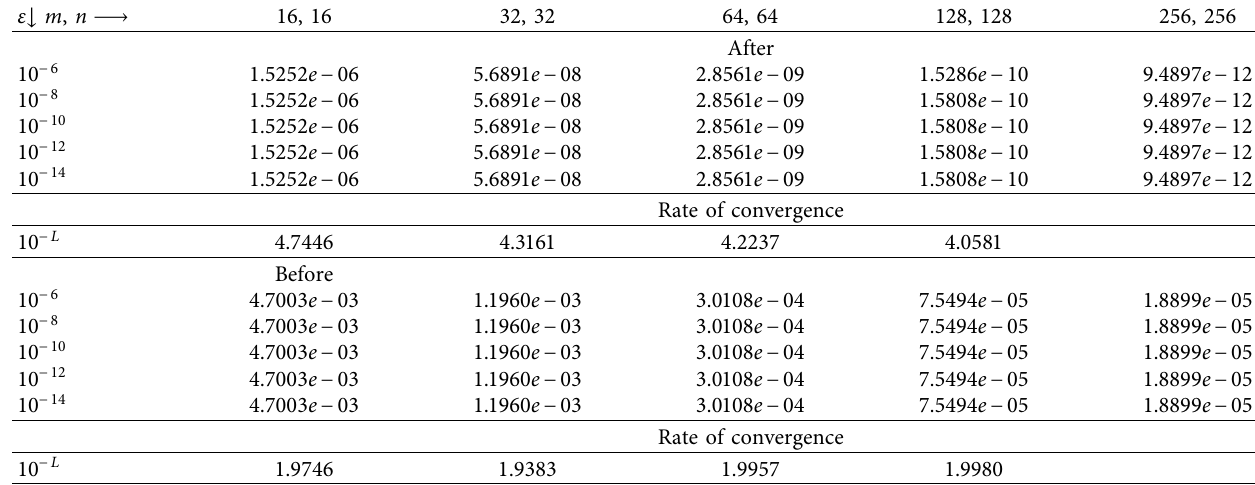
Table 2: Maximum absolute pointwise error and rate of convergence for Example 2 before and after the Richardson extrapolation method applied, where L ≥ 6.